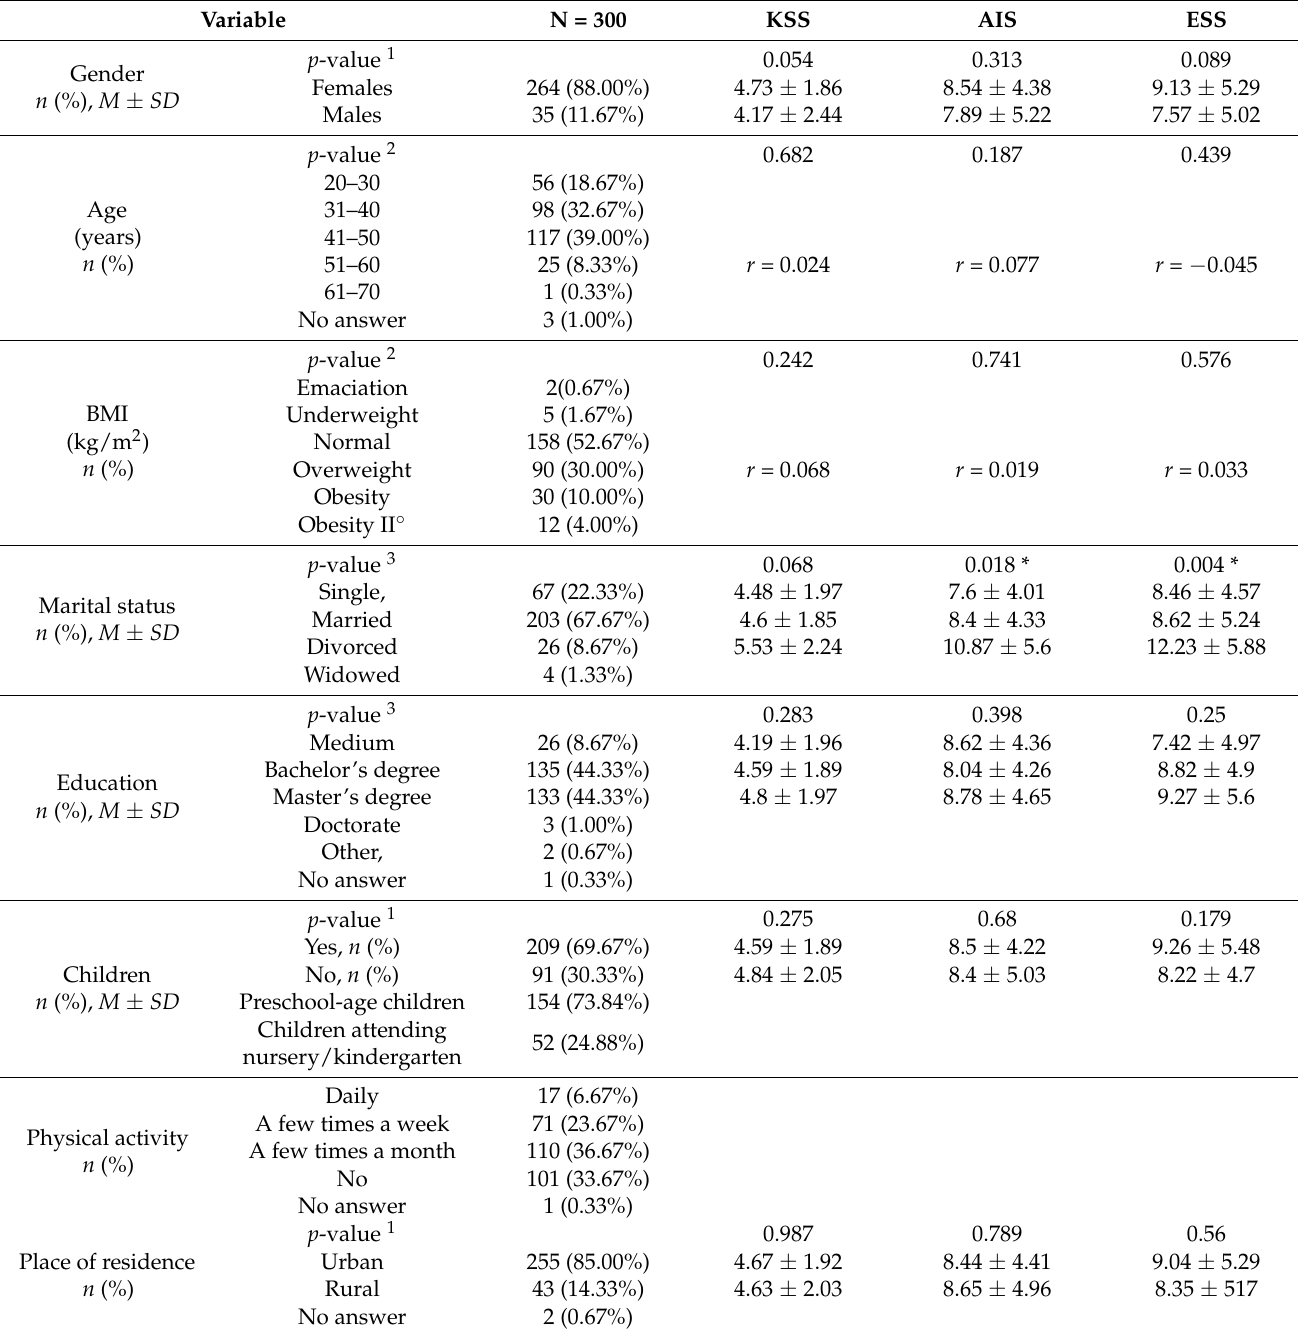
Table 1. The correlations between sleepiness scales and characteristics of the study